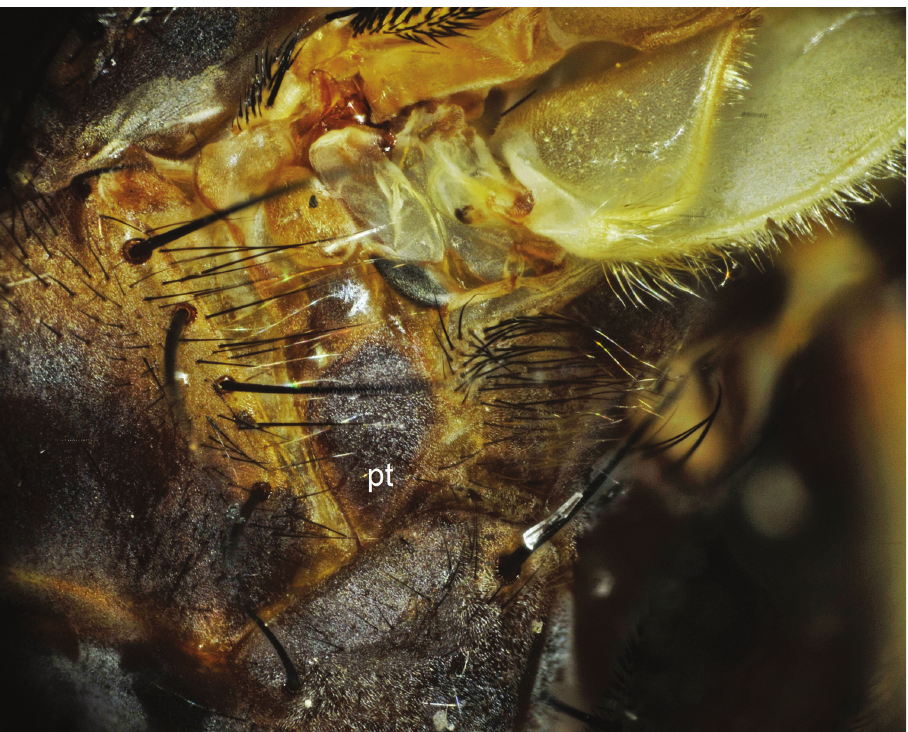
Figure 6. Pteropleuron (pt) of Bengalia emarginata Malloch, which is mostly clothed in black